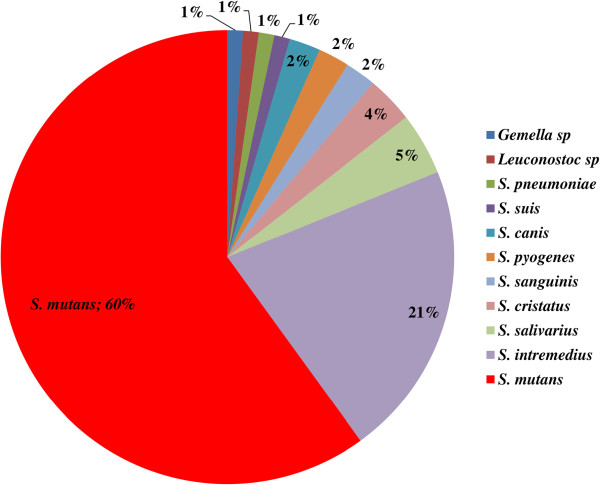
Percentage of Streptococcus species in the material using a selective medium HLR-S. The results of phenotypic analysis using the biochemical test.